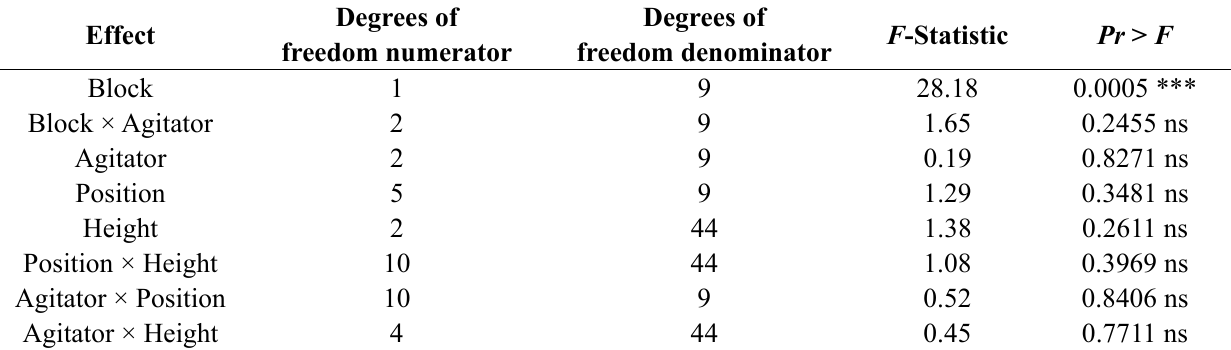
Table 1. Type 3 tests of the fixed effects of dry matter (DM) content on the full model alpha =